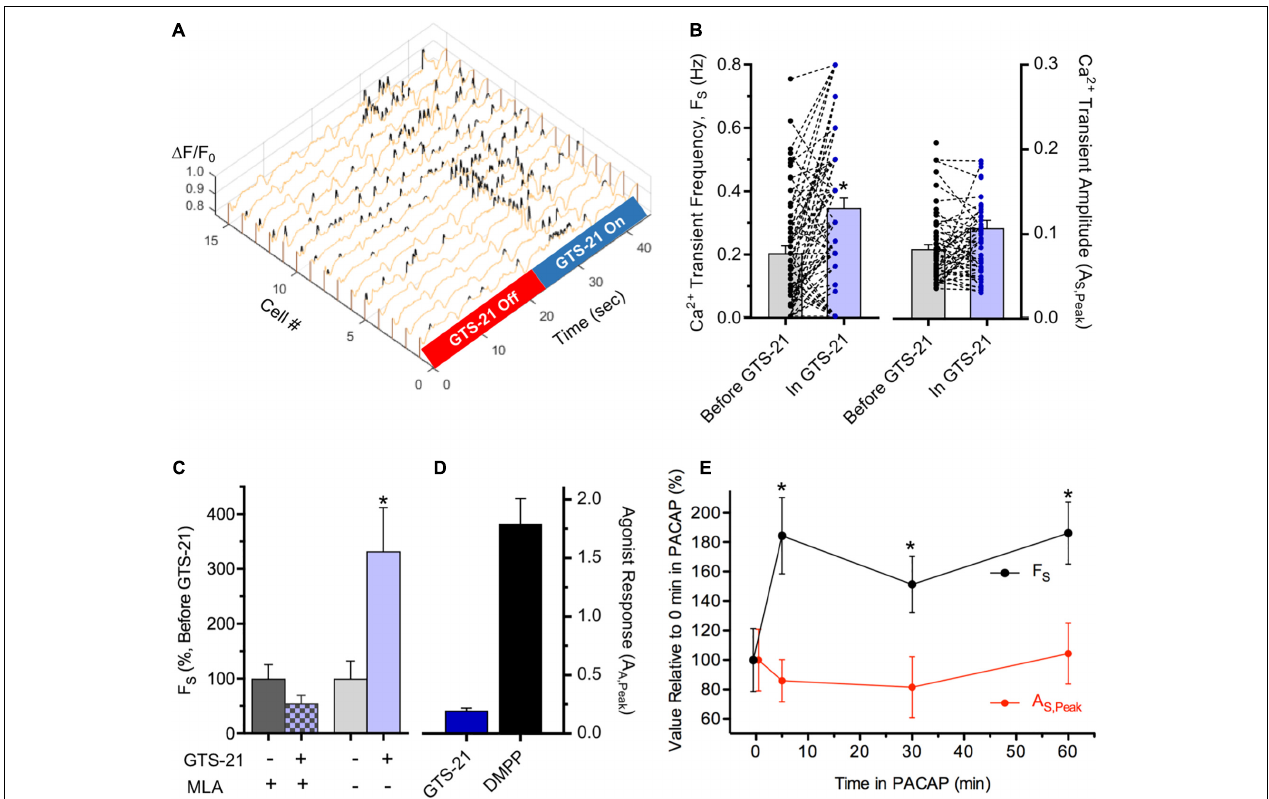
FIGURE 6 | Modulation of synapse-dependent spontaneous Ca 2 + transients. (A–D) Modulation by α 7-nAChR activation. (A) Ca 2 + transient frequency (F S ) in cholinergic myenteric neurons increases during perfusion with GTS-21, an α 7-nAChR selective agonist. Exemplar 3D plot showing Ca 2 + (cid:49) F/F 0 transients in 15 neurons before and during puffer application of GTS-21 (10 µ M; 5 psi). (B) α 7-nAChR activation by GTS-21 selectively increases Ca 2 + transient frequency. Data presented as in Figure 3 . Overall, GTS-21 increased Ca 2 + transient F S by 126 ± 25% (left) in neurons exposed to GTS-21 compared to F S in the same